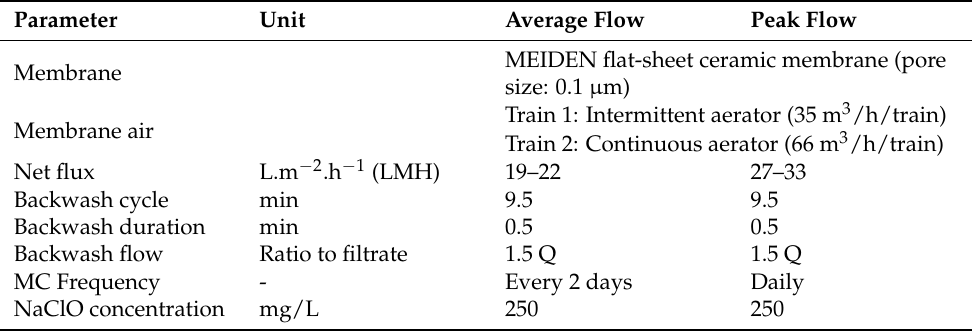
Table 2. The operating conditions for the MBR